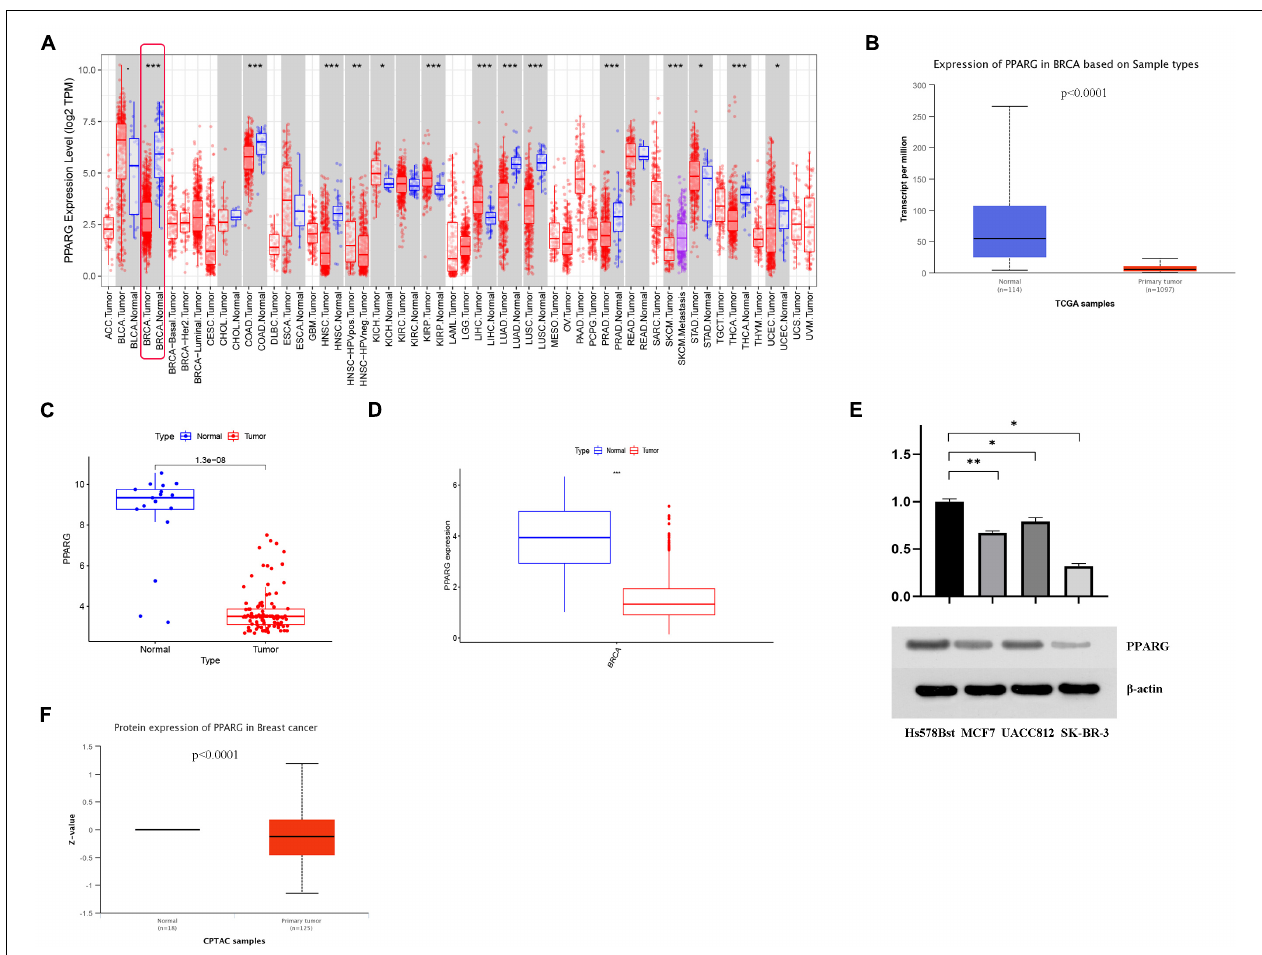
FIGURE 3 | The expression level of PPARG in BRCA. (A) The TIMER database was used to evaluate the mRNA expression of PPARG. (B) The UALCAN database was used to evaluate the mRNA expression of PPARG. (C) The mRNA expression of PPARG was assessed using data from GEO. (D) The mRNA expression of PPARG was assessed using data from TCGA. (E) Western blot analysis results showed that compared with normal breast cell line (Hs 578Bst), the expression of PPARG in BRCA cell line (MCF7, UACC812, and SK-BR-3) was significantly reduced. (F) The UALCAN database was used to evaluate the protein expression of PPARG. * P < 0.05, ** P < 0.01, *** P <